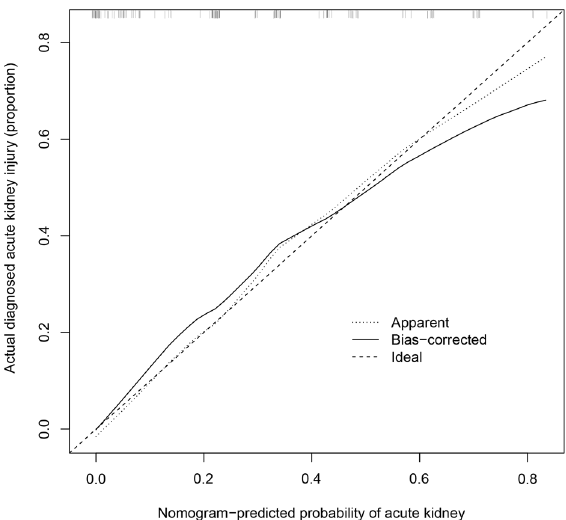
Figure 4. Calibration curves for the nomogram of AKI.